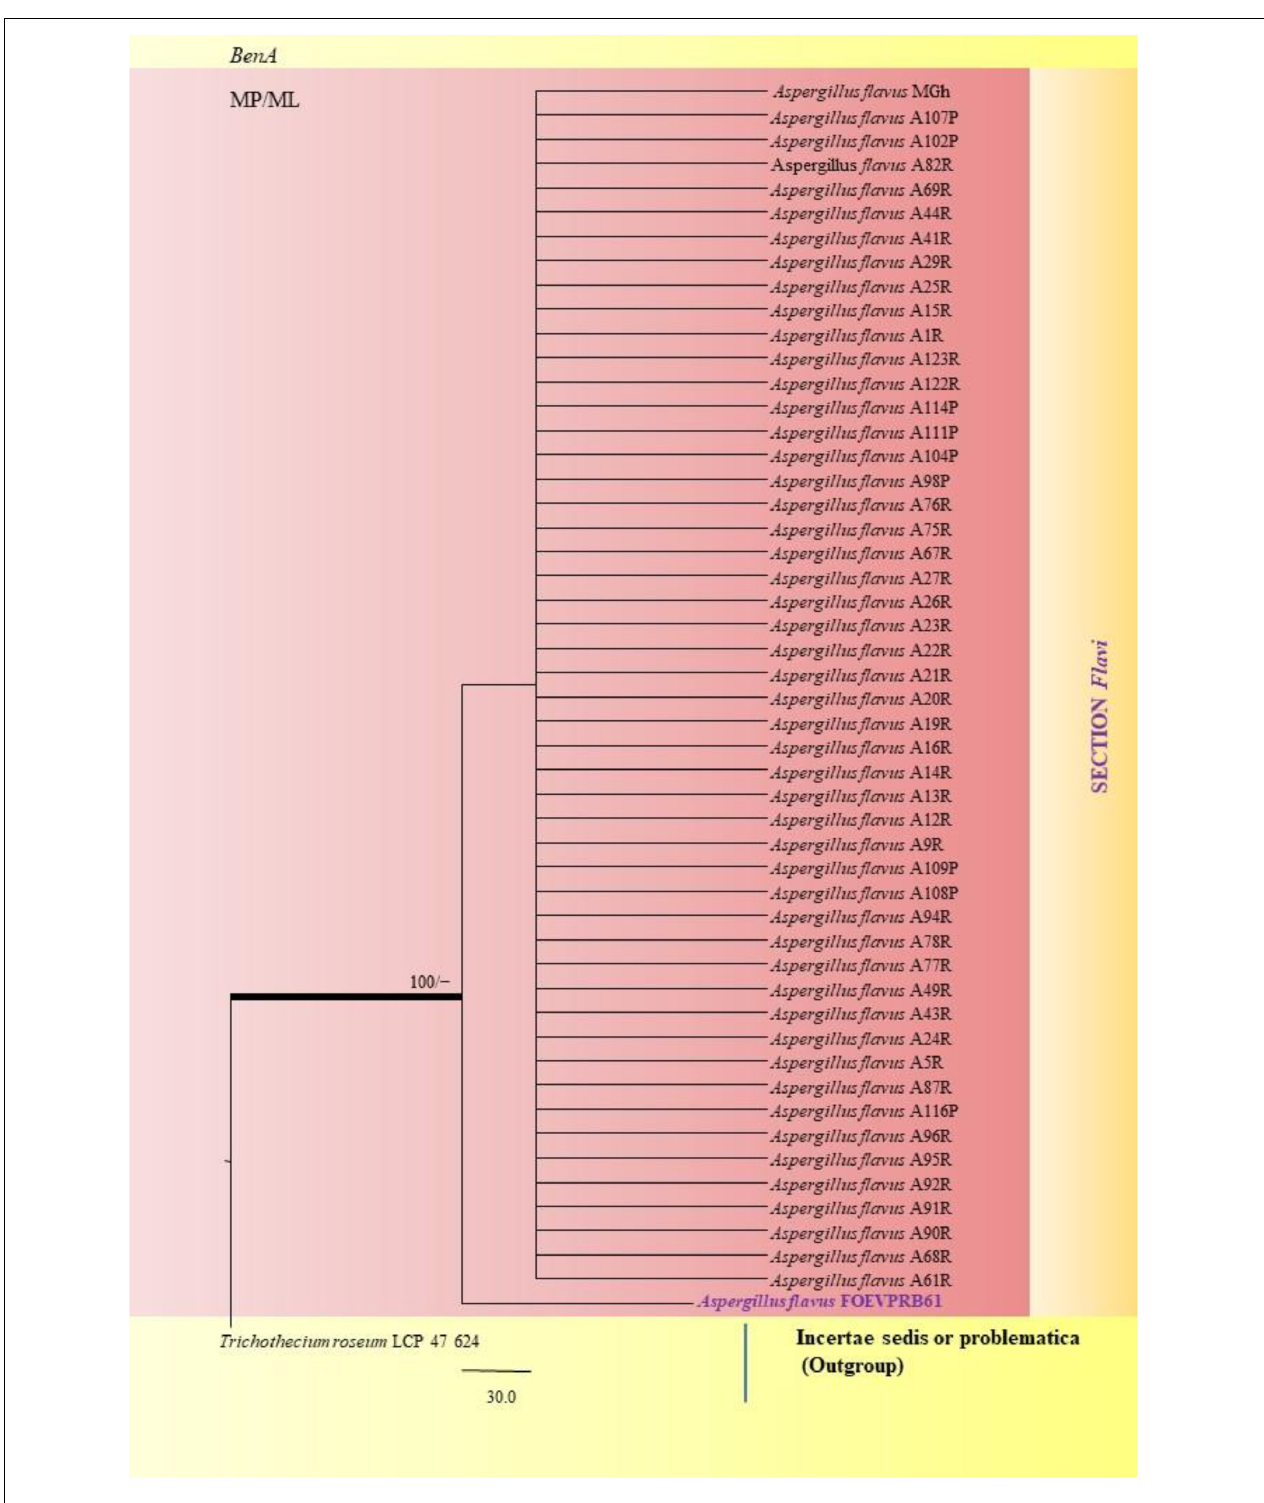
FIGURE 11 | A phylogenetic tree (taxon branching diagram) which presents the genetic analysis of the Aspergillus flavus FOEVPRB61 clade belonging to the Section Flavi , exhibiting a maximum parsimony analysis of partial β -tubulin concatenated sequences, acquired. Bootstrap (bs) values ≥ 70% are designated at the nodes for maximum parsimony (MP) and maximum likelihood (ML) methods; branches with values ≥ 95% bs are bold black. A specific isolate code was mentioned as a suffix to the species name. Hyphen (-) represents the range of support values for parsimony and RAxML analyses of below 70%. Our isolate, which is marked in purple, was rooted using Trichothecium roseum LCP 47